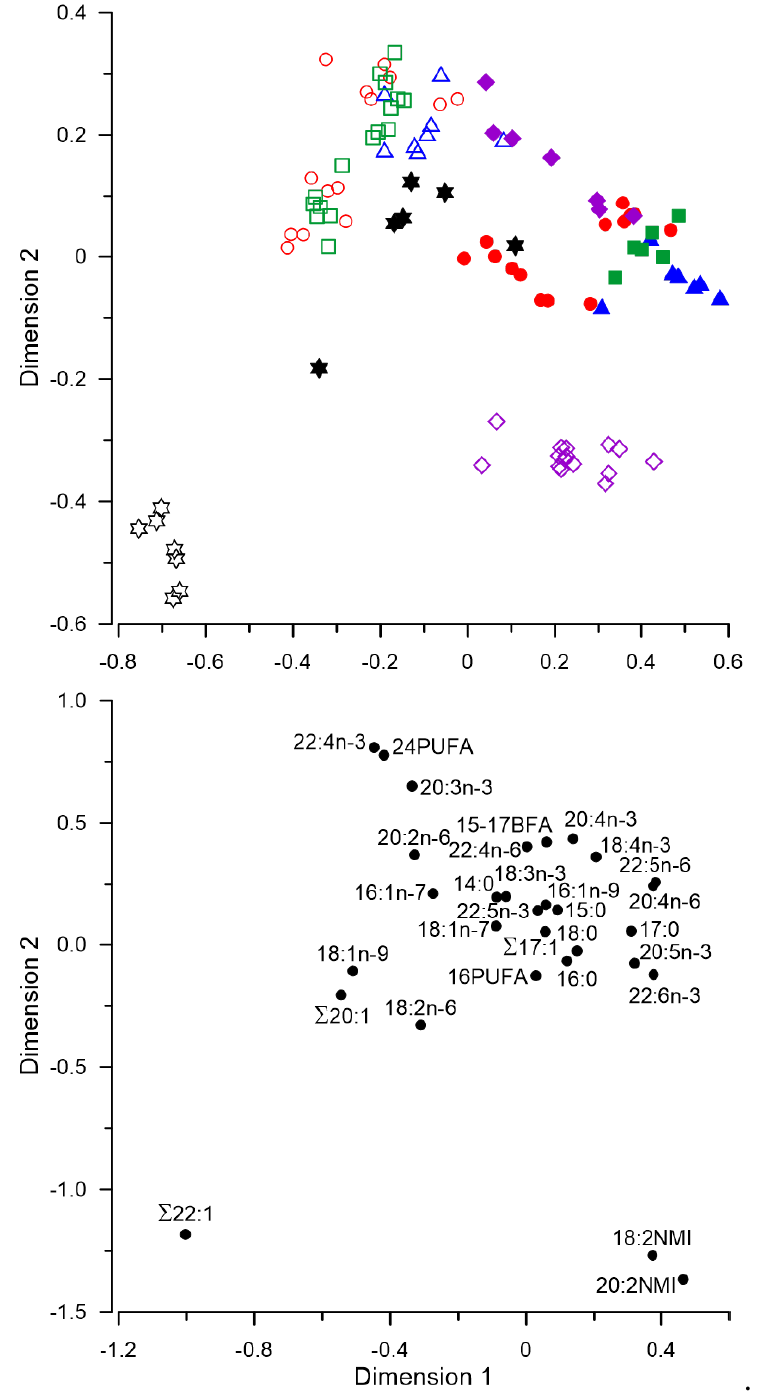
Figure 2. Canonical correspondence analysis of levels of fatty acids (% of the total) in species of genus Salvelinus : open circles—boganid charr S. boganidae ; open squares—Dryagin’s char Salvelinus drjagini ; open triangles—goggle-eyed charr ( Salvelinus alpinus complex; closed circles—Arctic charr Salvelinus alpinus from Lake Tokko; closed triangles— S. alpinus from Lake Leprindo; closed squares— S. alpinus from Lake Chepa-2; closed diamonds— S. alpinus from Lake Chepa-4; closed stars— S. alpinus from Lake Ladog; open stars— S. alpinus from the Ropsha farm; open diamonds—brook trout Salvelinus fontinalis from the aquaculture of Timiryazev Academy. Dimension 1 and Dimension 2 represented 43.3% and 20.8% of inertia, respectively.